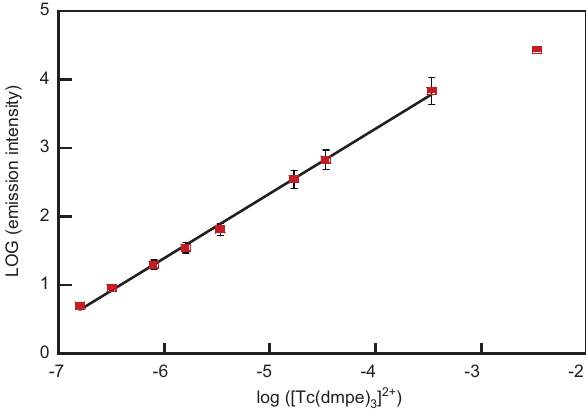
Figure 14 Spectroelectrochemical sensor calibration curve for the ] 2 + (in molarity) with precon- luminescence detection of [Tc(dmpe) 3 centration in a polystyrene-block-poly(ethylene-ran-butylene)- block-polystyrene (SSEBS) film. Reprinted with permission